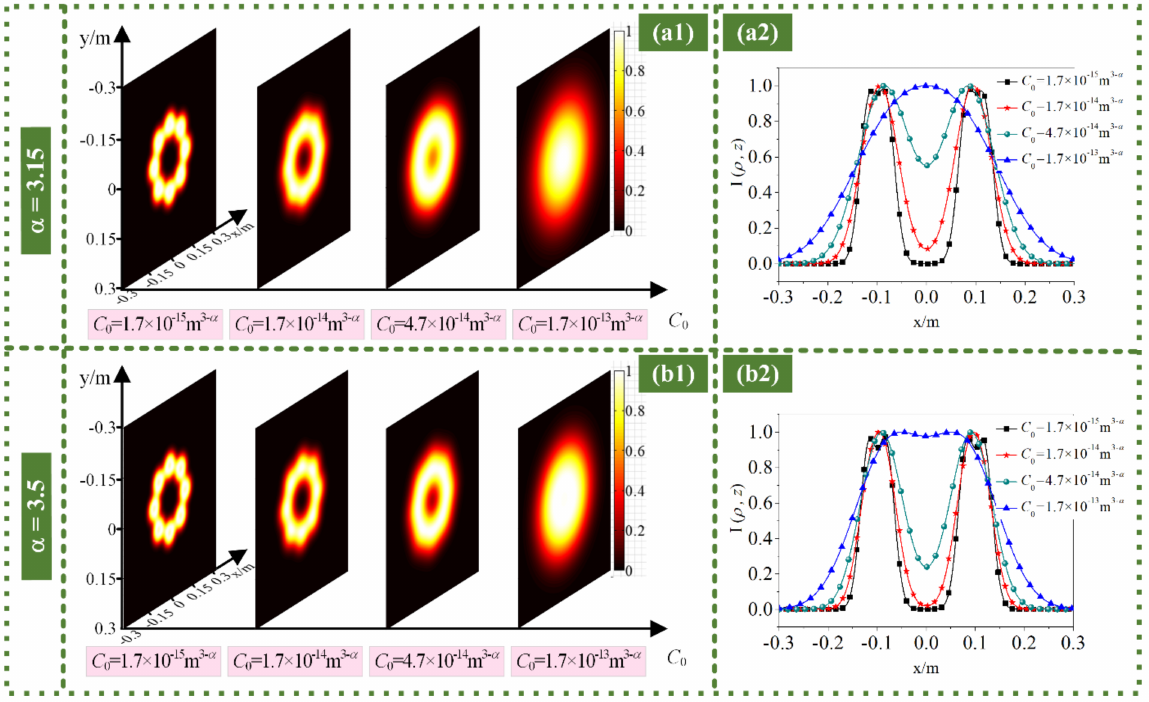
Figure 8. Intensity ( a1 , b1 ) distributions and ( a2 , b2 ) profiles of RPLPCV beam array through non-Kolmogorov turbulence for different C 0 values with generalized exponent factors ( a ) α = 3.15 and ( b ) α =